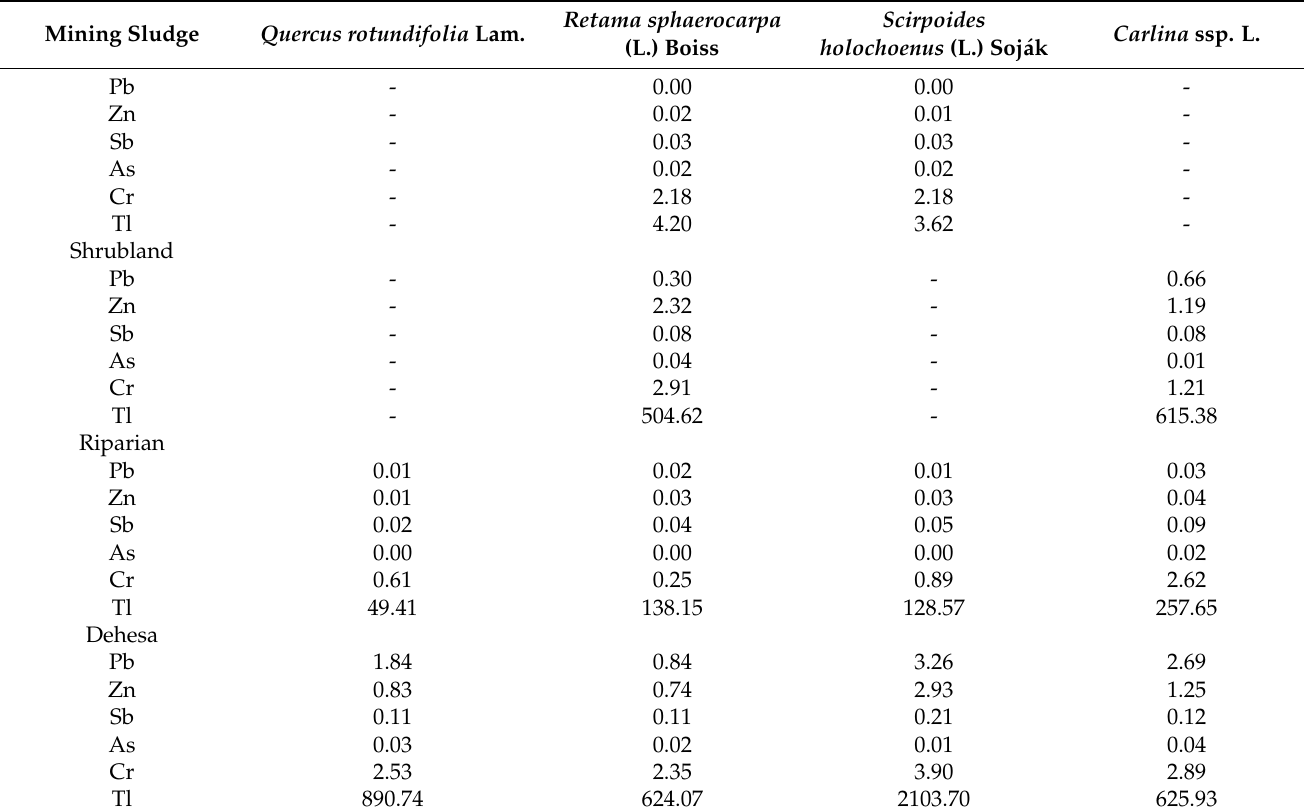
Table 3. Bioaccumulation factor. Mining sludge (n = 4), riparian (n = 29), dehesa (n = 49), shrubland (n =